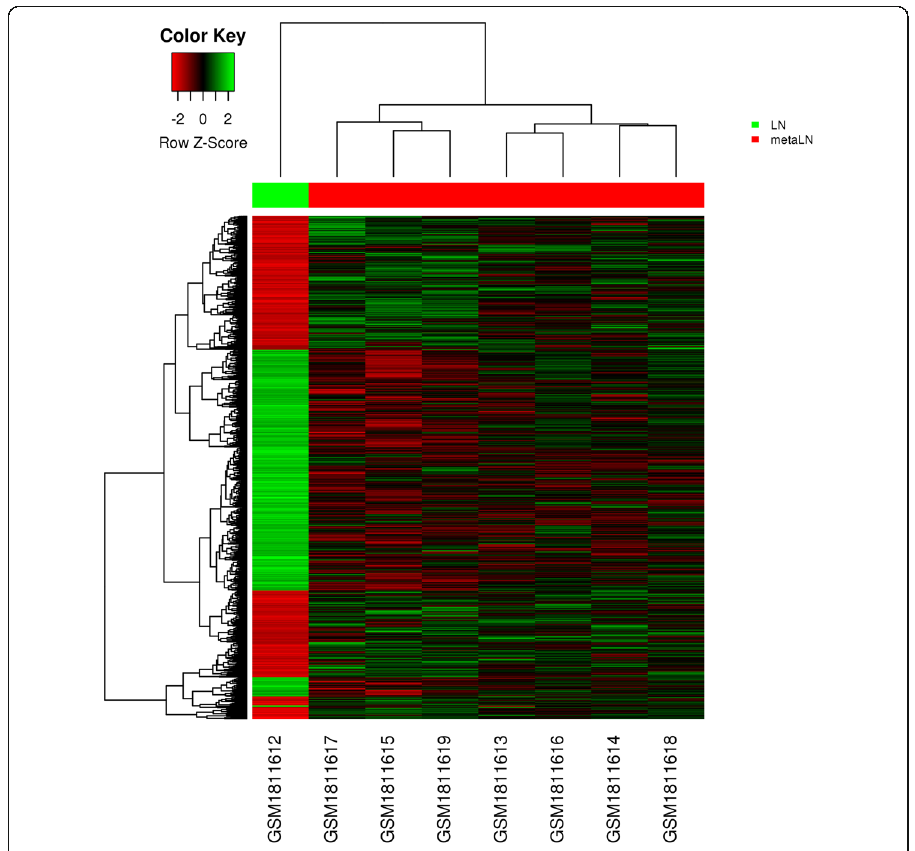
Fig. 1 Heat map of distribution of DEGs in GSE70604. The comparisons of gene expression profiles were made between lymph nodes with metastasis of oral squamous cell carcinoma (OSCC) and normal lymph